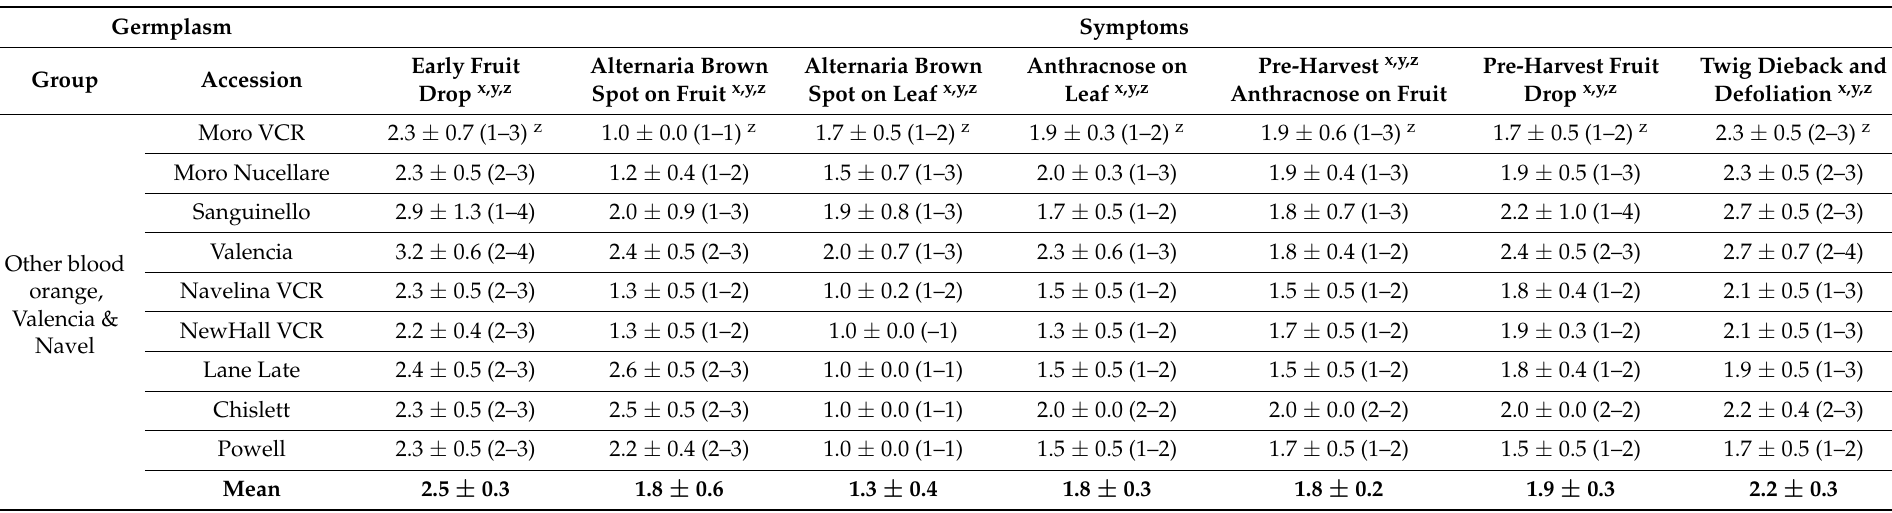
x Disease data for each cultivar/clone are the means of three replicates, each relative to three monitoring periods (2010–2013, 2014–2017, 2018–2020), obtained from 20 representative Citrus production areas (at least one area monitored over two periods) in eastern Sicily. y Mean disease scores were calculated according to an empirical 0-to-5 disease incidence scale taking into account the percentage of citrus organs in the canopy where 0 = healthy canopy; 1 = from 1 to 5% of infected fruit/leaves/twigs in the canopy; 2 = from 6 to 15% of infected fruit/leaves/twigs in the canopy; 3 = from 16 to 30% of infected fruit/leaves/twigs in the canopy; 4 = from 31 to 60% of infected fruit/leaves/twigs in the canopy, 5 = from 61 up to 100% of infected fruit/leaves/twigs in the canopy. z Data are followed by standard deviation value and relative class range (min–max) monitored through surveyed time and